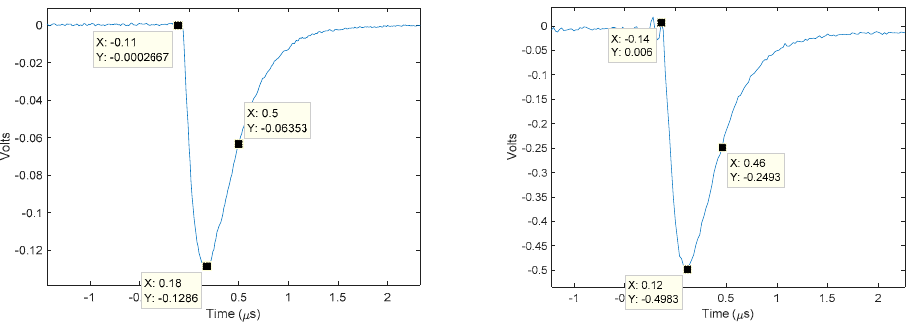
Figure 2. The response of NaI(Tl) detectors coupled to a fibre-optic link with low bandwidth. The response to a single photon emission of a 137 Cs calibration source ( left ) and the typical response to a laboratory discharge of a standard lightning impulse of 900 kV ( right ) are shown. This detector configuration is not capable of resolving multi-photon pile-ups for photon bursts occurring within the response time of the system (as evident from the response to a multi-photon burst of the detector shown on the right). The seemingly lower rise-time as can be clearly seen from both plots is caused by the limited bandwidth of the fibre-optic link. The fall-time of the waveforms is primarily determined by the typical scintillation decay-time of Nai(Tl). The calibration constant is calculated by assuming a simple linear relationship of the peak amplitude of the detected signal to the total-deposited energy at the detector. Such calibration, based only on the amplitude, is especially applicable to NaI(Tl) detectors coupled to fibre-optic links with a limited bandwidth. Please note that the calibration waveform shown above ( left ), is taken from another experiment with different calibrations, but it is still applicable for the measurement in this work in terms of the wave-shape.